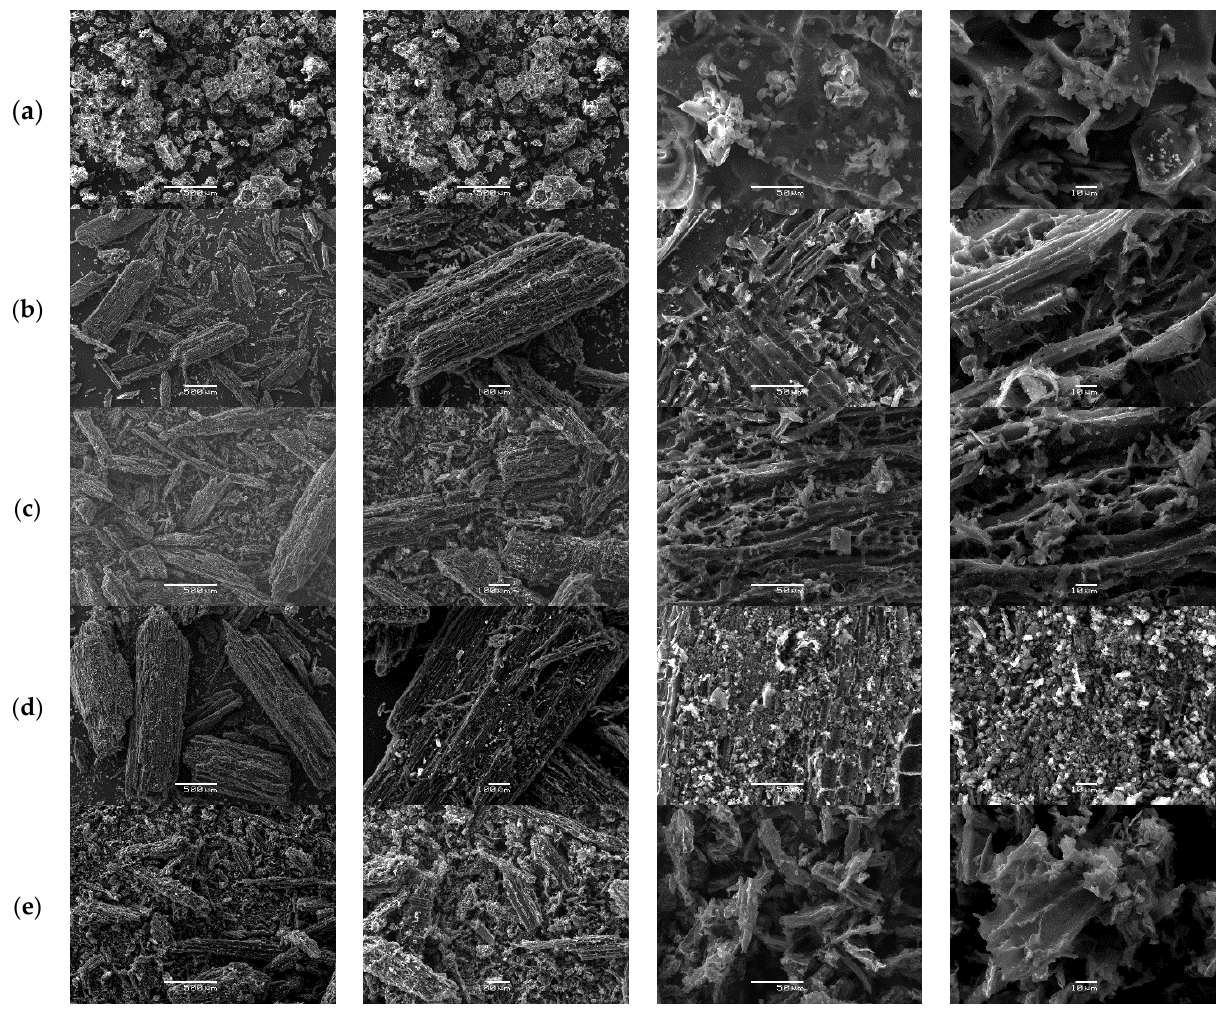
Figure 8. SEM images of the QS-P ( a ), QS-CO 2 ( b ), QS-CO 2 CV ( c ), QS-H 2 O ( d ), and QS-H 2 O CV ( e ). All images were taken with a magnification of 500 × , 100 × , 50 × , and 10 × ,